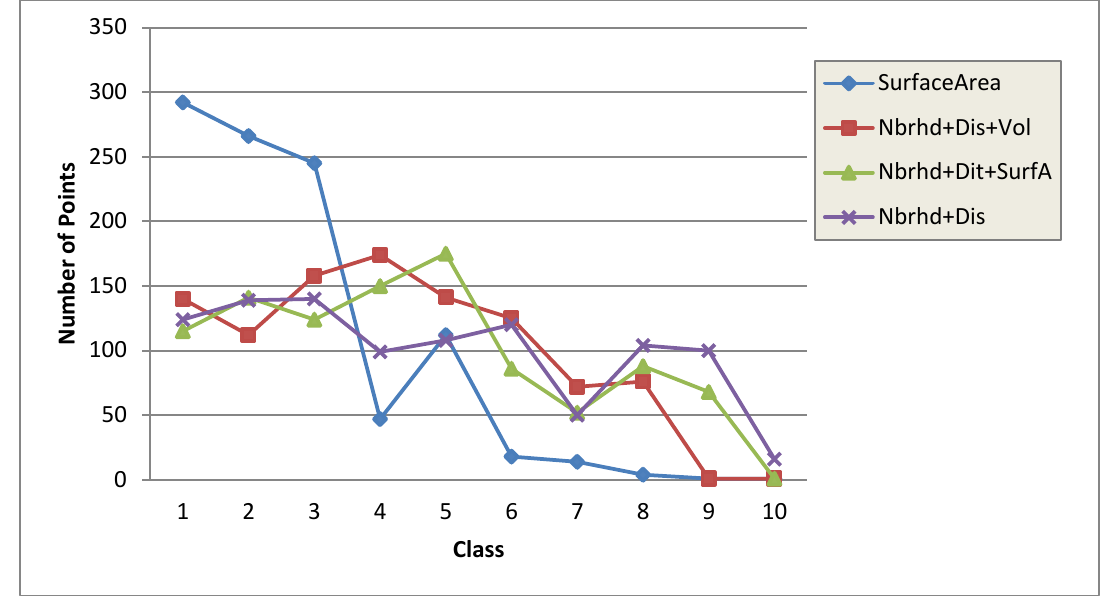
Figure 6. Statistics of the number of particles in 10 classes with different importance